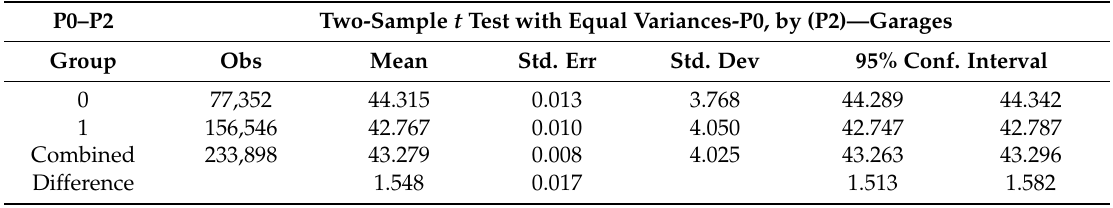
Table 4 . Results: P0 by P2: Variability 1548 nT between 0 and 1 with p-value: 0.004. Table 4. Results: P0 by P2: Variability 1548 nT between 0 and 1 with p -value: